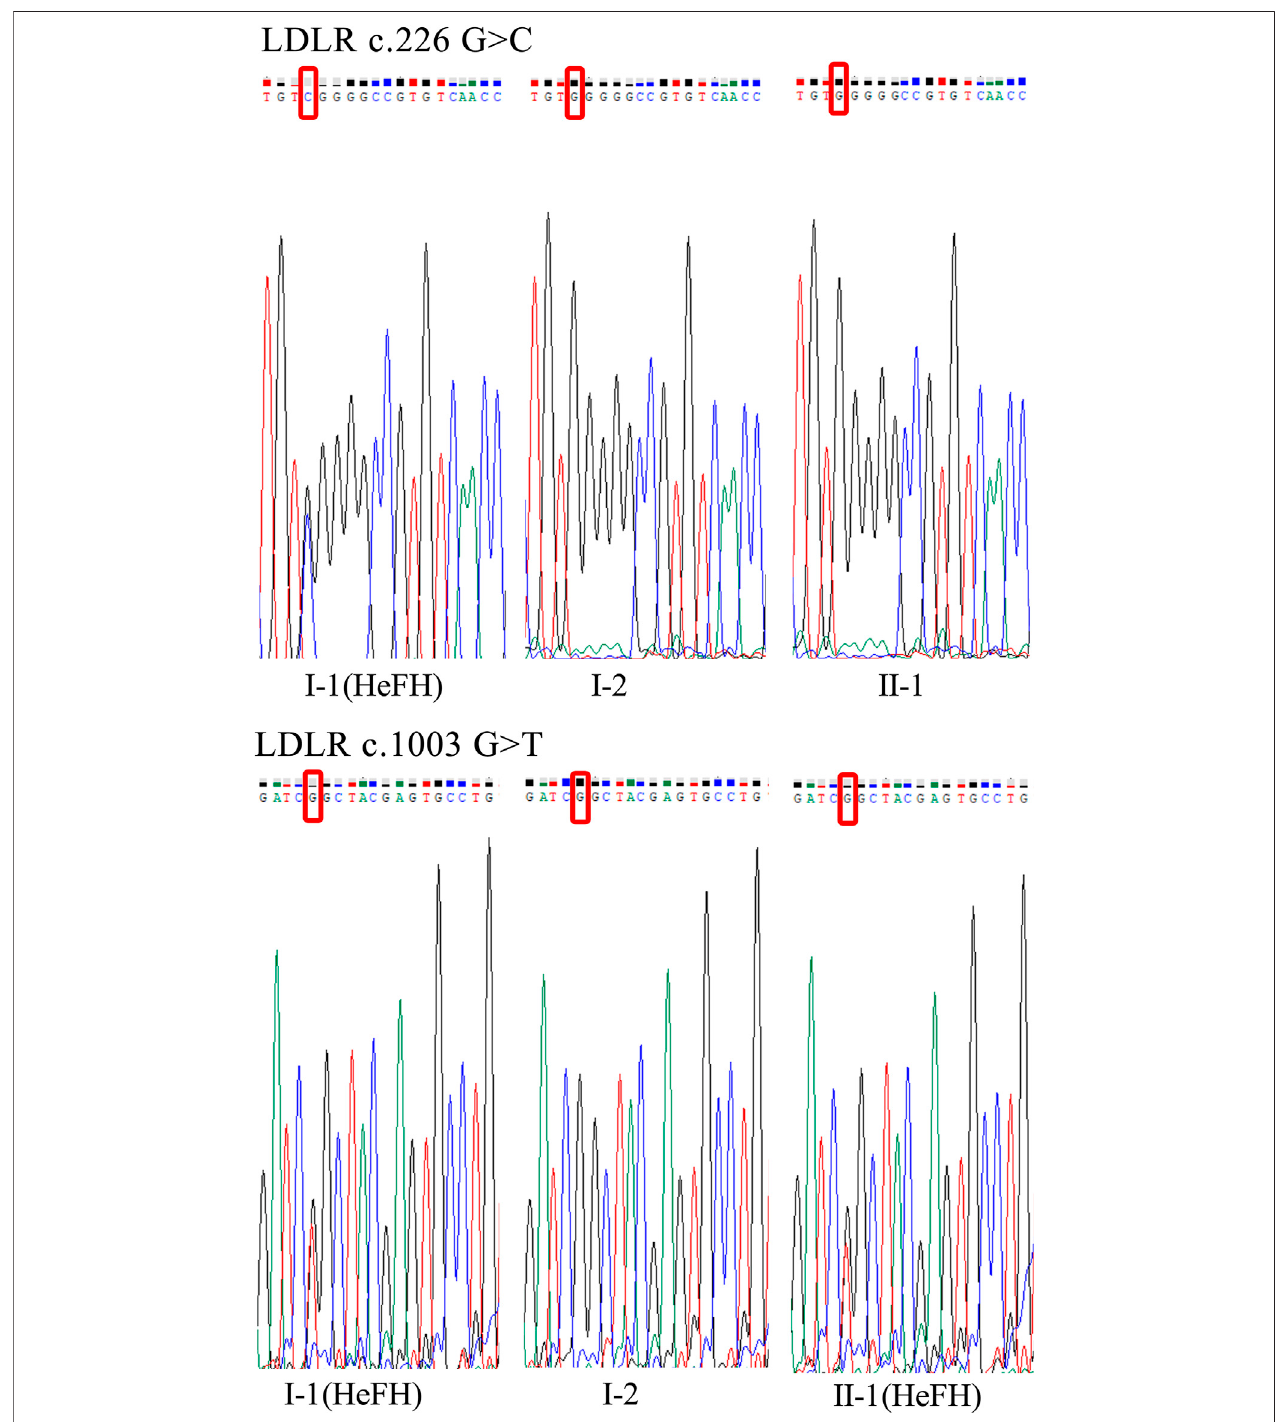
FIGURE2| TargetsequencesonLDLRbySangersequencing. Twodisease-causingLDLRvariants (LDLRc.226 G > C,c.1003 G > T)werefoundintheproband (I-1). The LDLR c.1003 G > T variant was found in the proband ’ s daughter (II-1).